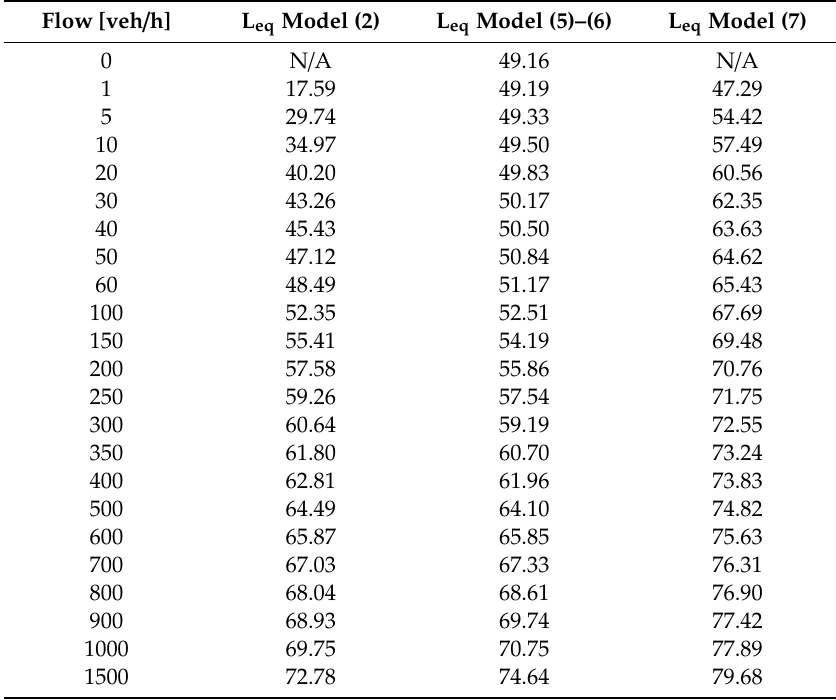
Table 2. Comparison of